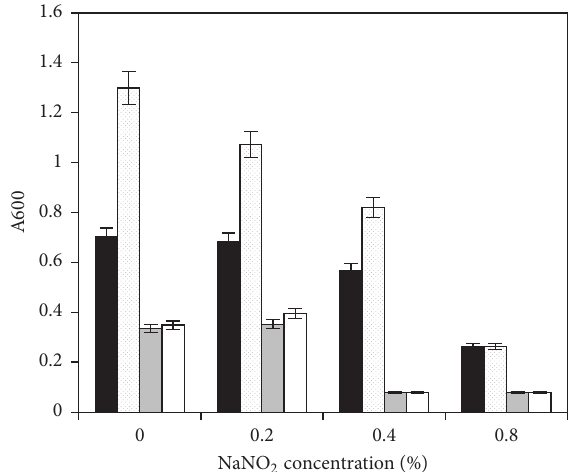
Figure 5: Effect of trehalose on the growth of wild type C. perfringens ATCC 13124 and mutant 13124 GR in BHI medium in the presence of different concentrations of sodium nitrite. Black bars, wild type without trehalose; dotted bars, wild type with trehalose; gray bars, mutant without trehalose; white bars, mutant with trehalose.